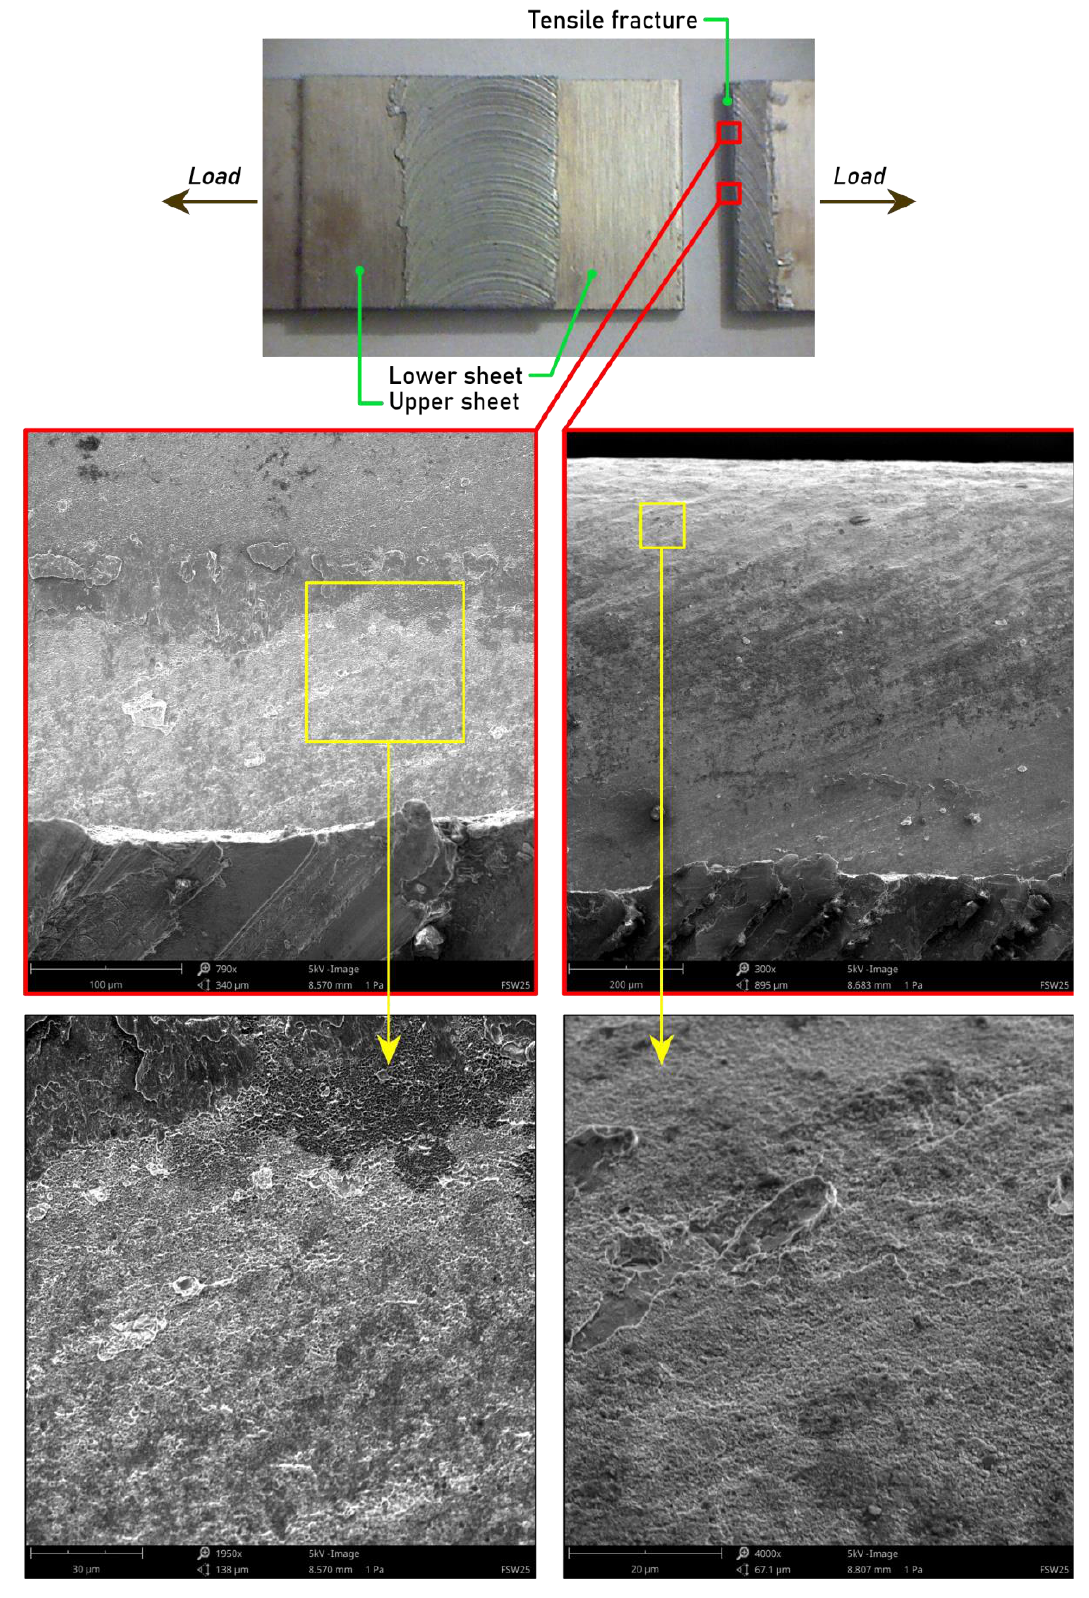
Figure 12. SEM images of a fracture surface of an FSW weld joint made using the following parameters: pin length d = 1.9 mm, welding speed f = 400 mm/min, and tool rotational speed n = 800 rpm.